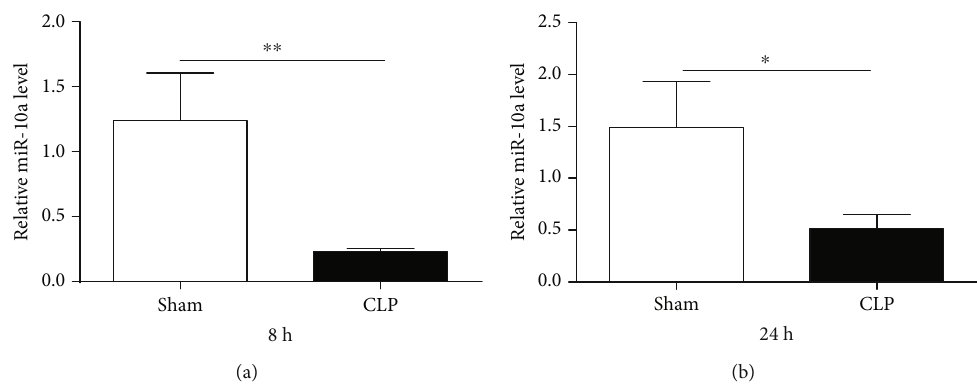
Figure 6: miR-10a expression in a mouse model of sepsis. PBMC were isolated from whole blood of C57BL/6 mice after 8 h (a) and 24h (b) of sham or CLP surgery. miR-10a expression was determined via qRT-PCR. Data are presented as mean ± SEM , n = 6 . ∗ p < 0 : 05 and ∗∗ p < 0 : 01